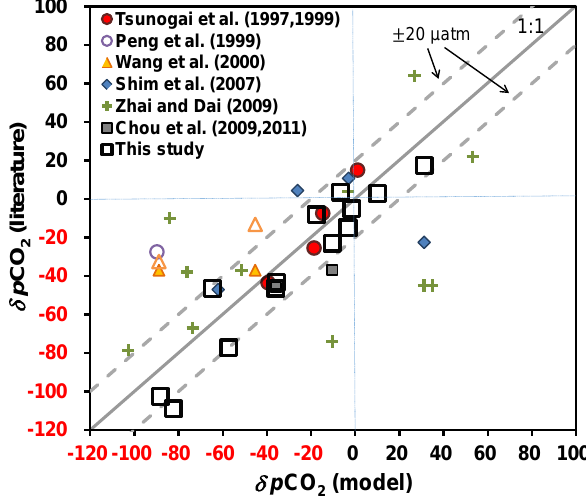
Figure 8. δp CO 2 comparison between the data retrieved from pub- lished references and this study and those generated by the model at the same surveying